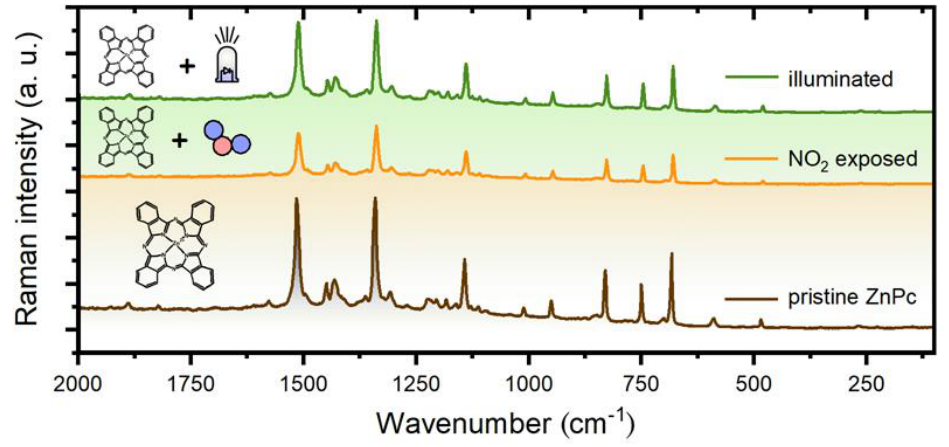
Figure 7. SERS spectra of a ZnPc layer in 3 various states (pristine, after NO 2 exposure, and after illumination).